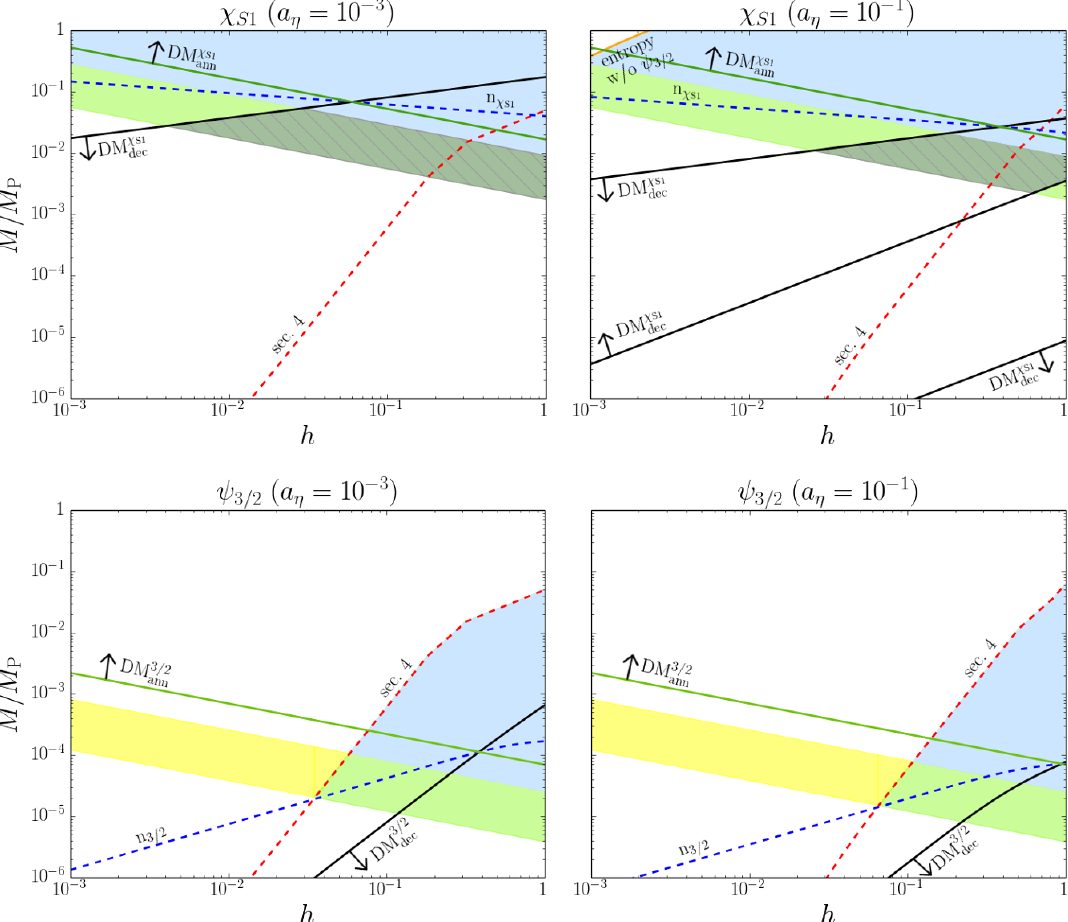
Figure 6 . The same as in (cid:12)gure 5 for a thermal cross section h (cid:27) ann v M(cid:28)l i = 10 (cid:0) 10 GeV (cid:0) 2 , and for small (large) coupling a (cid:17) = 10 (cid:0) 3 ( a (cid:17) = 10 (cid:0) 1